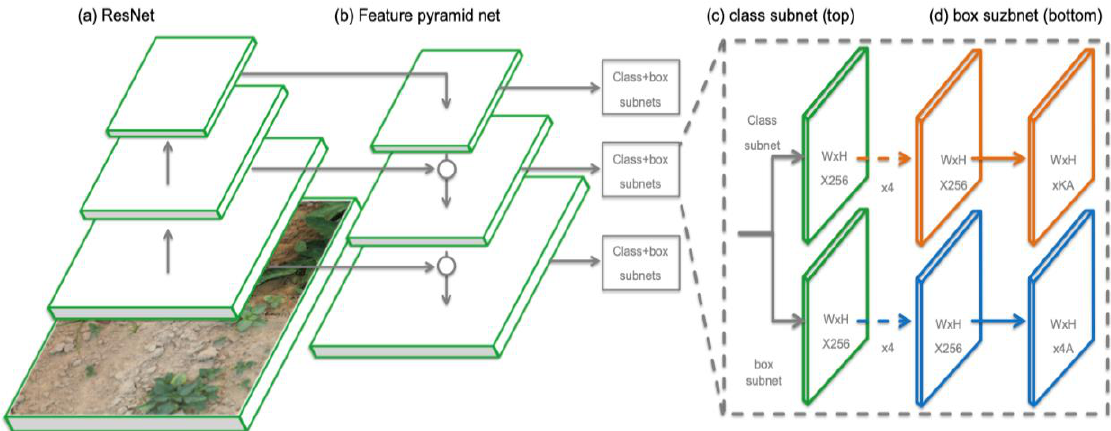
Figure 1. RetinaNet network architecture using one-stage to detect and classify objects. Backbone on top of a feedforward ResNet architecture ( a ) generates a rich, ( b ) multi-scale convolutional feature pyramid. To this backbone RetinaNet attaches two subnetworks, one for classifying anchor boxes ( c ) and one for regressing from anchor boxes to ground-truth object boxes ( d ).